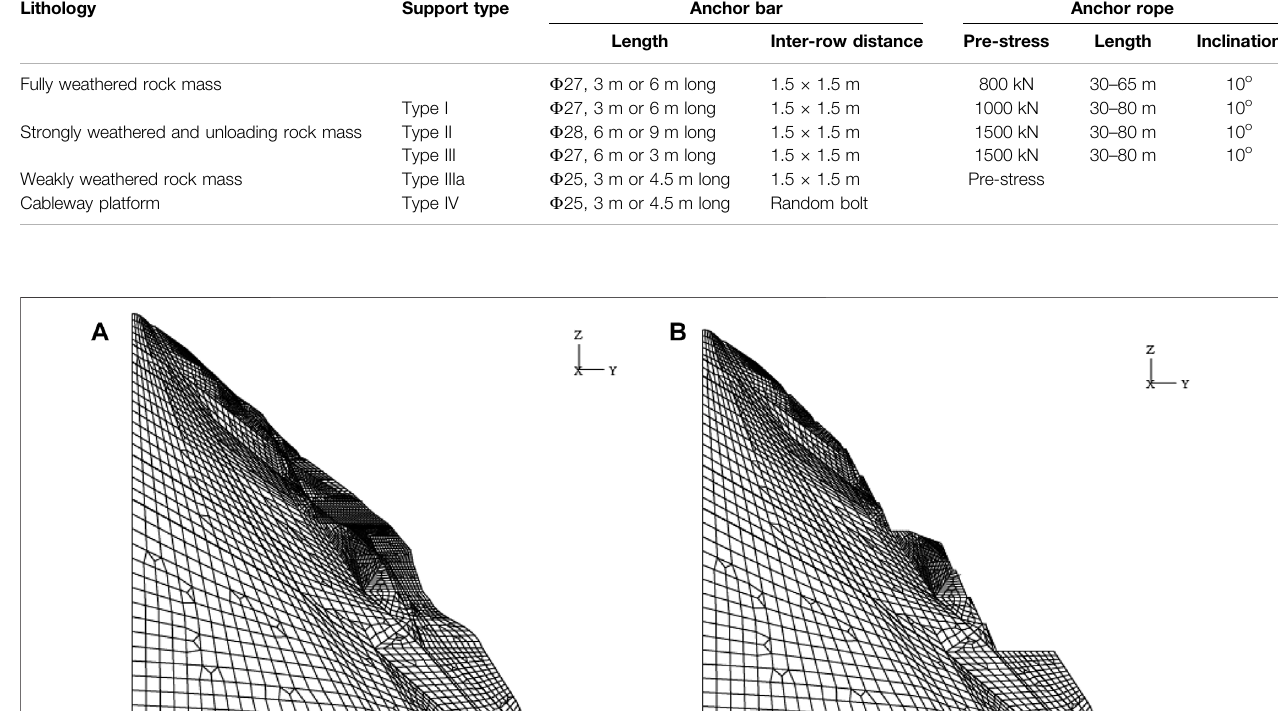
Frontiers in Earth Science |